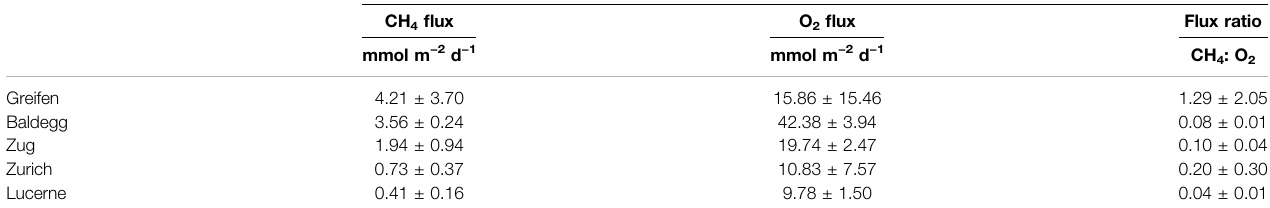
TABLE3| (A)ModeledCH 4 andO 2 fl uxesand fl uxratiosbylakeandstation.(B)Lake-speci fi caverage±standarddeviation(SD)ofmodeledCH 4 andO 2 fl uxesand fl uxratios shown in (A). At the standard stoichiometry for aerobic methane oxidation 2 O 2 are reduced per CH 4 oxidized. Thus, at a fl ux ratio of 0.03, approximately 6% of O 2 that enters sediments is consumed by aerobic methane oxidation, assuming that all methane is oxidized in sediments via the standard stoichiometry of aerobic methane oxidation.